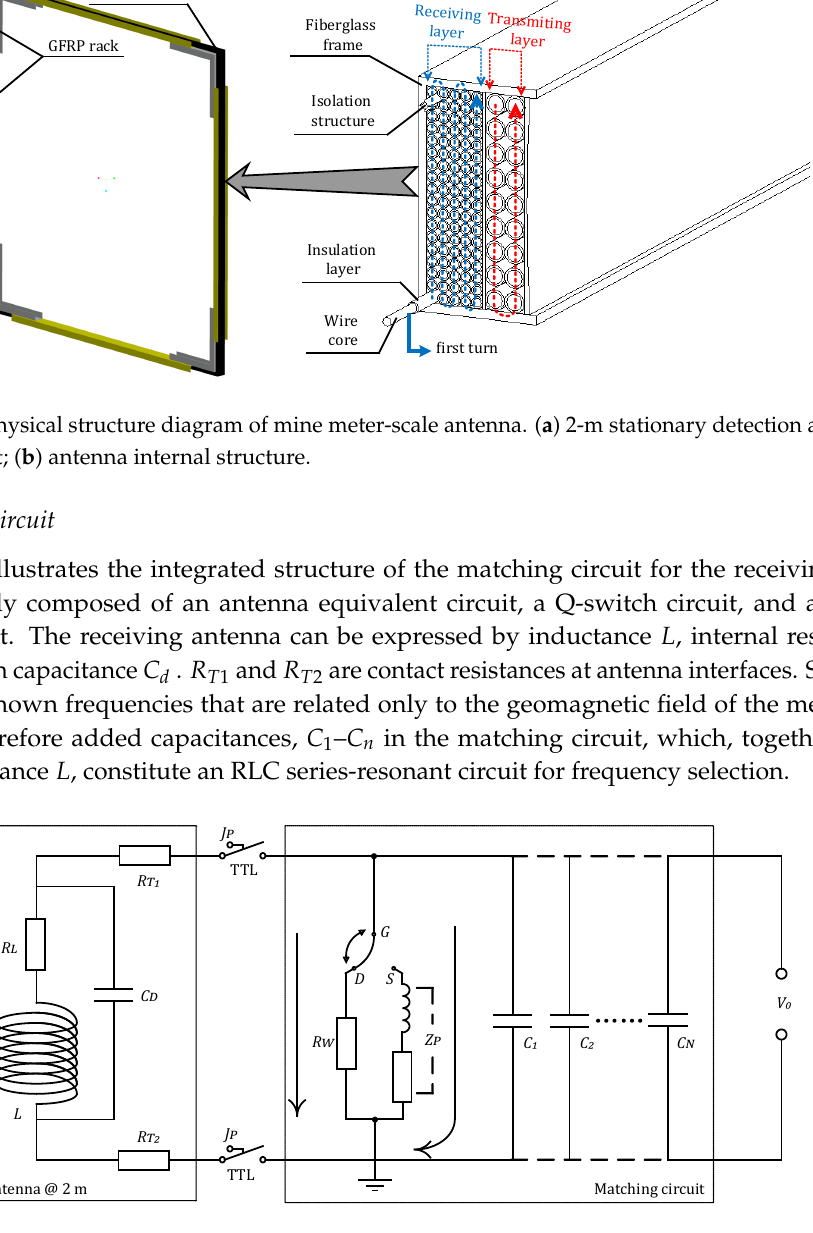
Figure 5. Matching circuit for the multi-turn high inductance